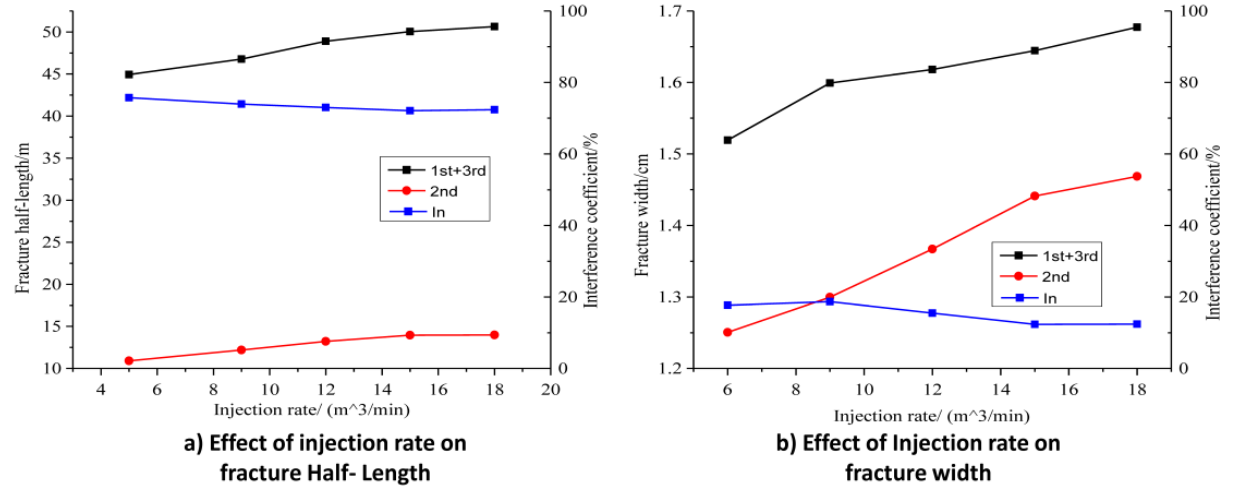
Figure 8: Results of fracture morphology for fracture propagation when the injection rate is